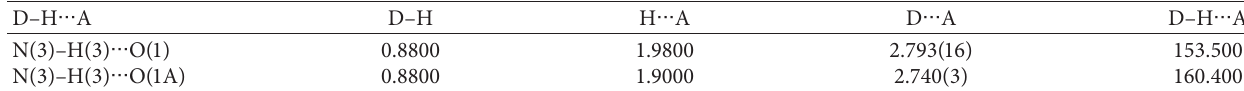
Figure 3: The structure of 2 (green lines represent the H-bonds). Table 7: Hydrogen bonds for the complex 2 (˚A and ° ).